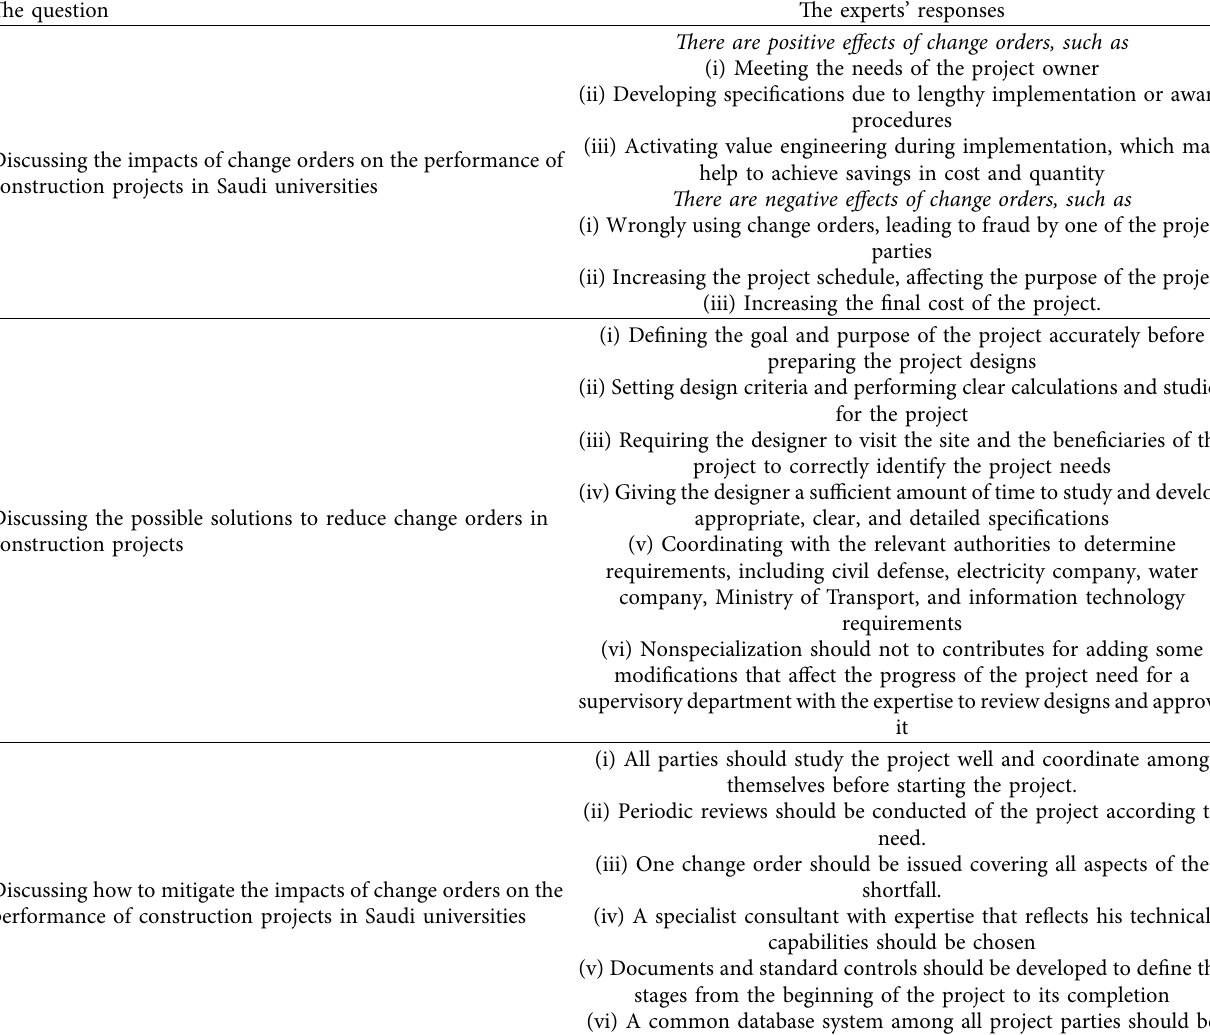
Table 4: List of the interview results with the experts.